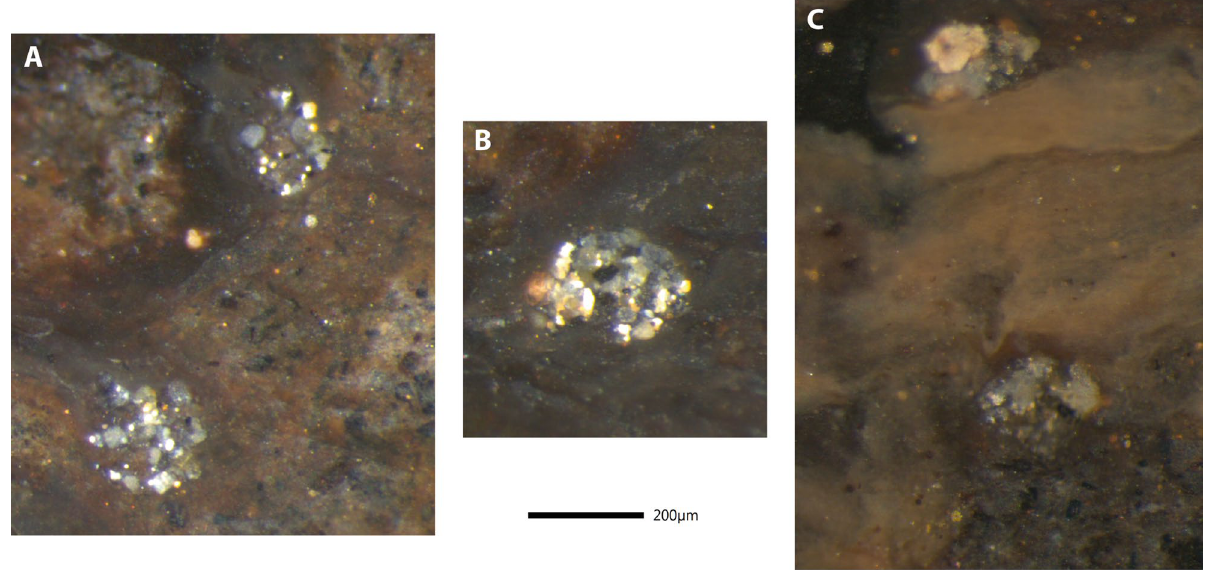
Figure 8. Zoomed photographs of the eyes of two specimens. ( A ) SF-MeI 5933 A; ( B ) SF-MeI 5933 B; ( C ) SF-MeI 16018